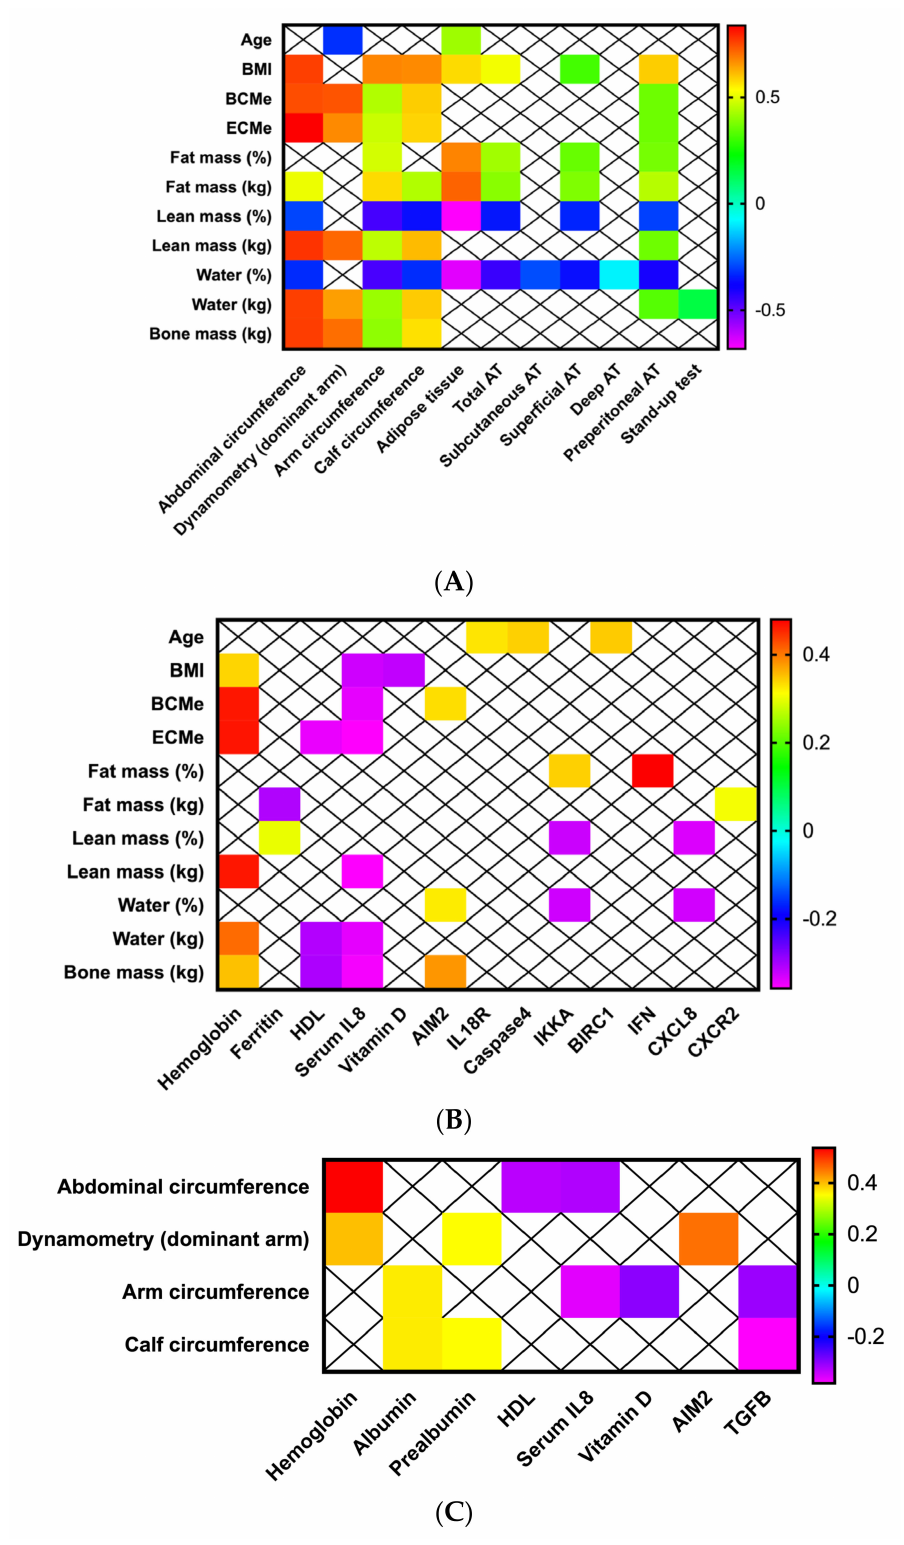
Figure 2. Morphofunctional nutritional assessment in patients with head and neck cancers. Corre- lations between ( A ) Bioimpedance analysis, anthropometric evaluation, muscle and adipose tissue echography; ( B ) Bioimpedance analysis, biochemical and molecular parameters; ( C ) Anthropometric, functional, biochemical and molecular